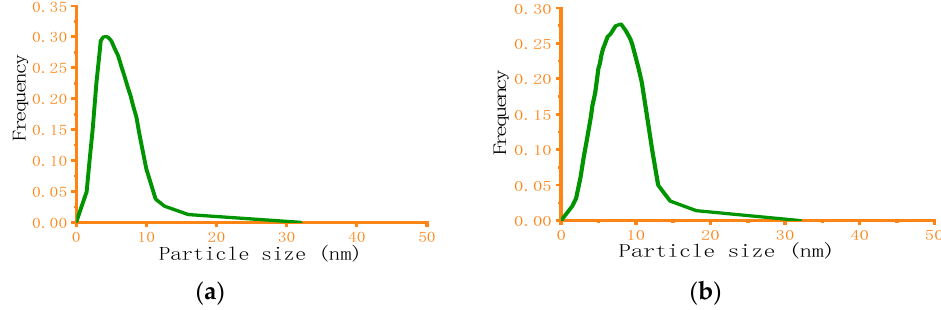
Figure 7. Comparison of ( a ) length number diameter distribution ( D 1,0 ) (m) obtained using surface growth only model for crystallization and ( b ) using combined aggregation and surface growth model.